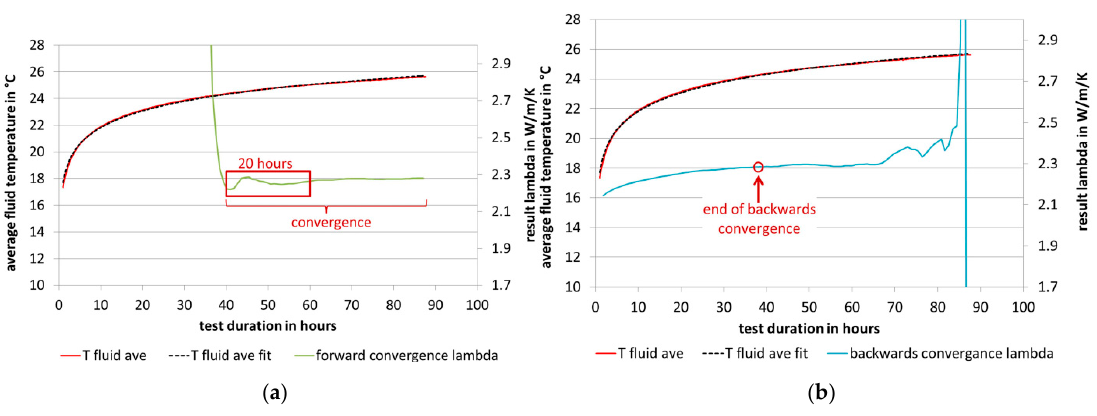
Figure 3. ( a ) Sequential Forward-Evaluation, ( b ) Sequential Backward-Evaluation [121].